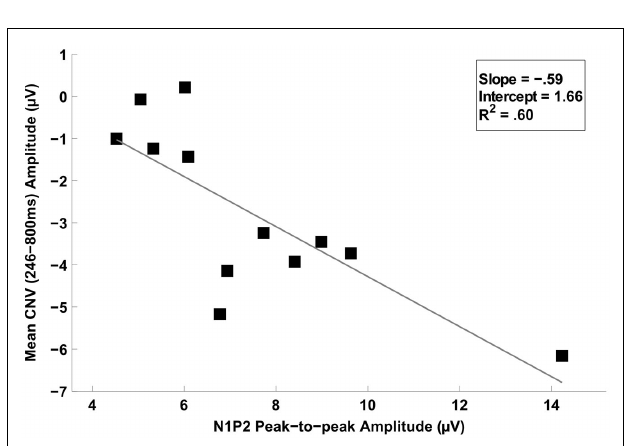
and Cz) for the two response categories, computed using epochs from the three intermediate probe durations. There was no statistically